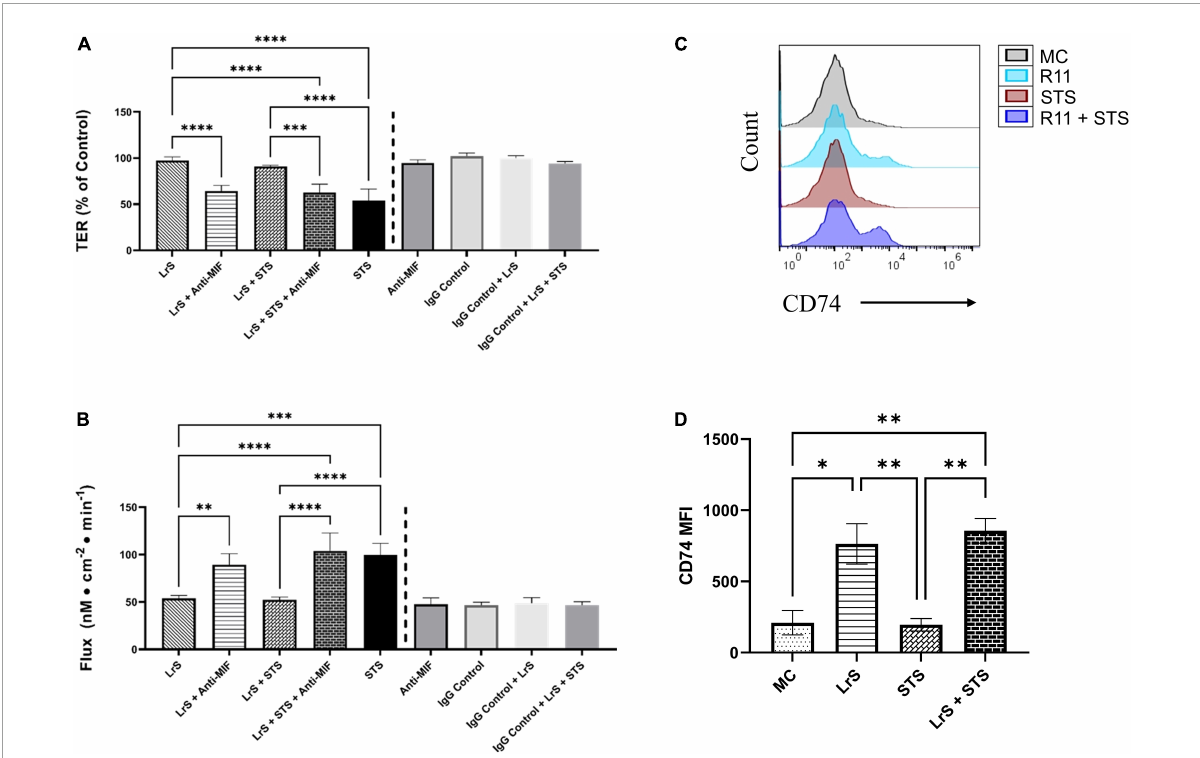
FIGURE7 The impact of the LrS on T84 IEC barrier function and integrity is abrogated by the addition of a MIF blocking antibody. (A) Transepithelial resistance (TER) was measured following challenge of T84 IECs with the LrS, STS, or a combination of the challenges with an anti-MIF antibody or isotype controls (0.5 µ g/mL) for 24 h ( n = 3). (B) T84 IEC monolayer permeability was determined by measuring the amount of flux of FITC-dextran following challenge ( n = 3). Significance is indicated as ∗ p < 0.05, ∗∗ p < 0.01, ∗∗∗ p < 0.001 as determined by one-way ANOVA